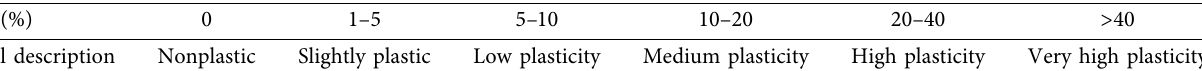
Table 4: Soil classification related to plasticity index